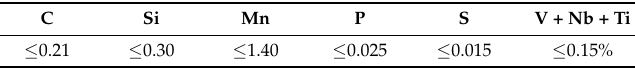
Table 1. Chemical compositions of J55 ERW steel pipe.